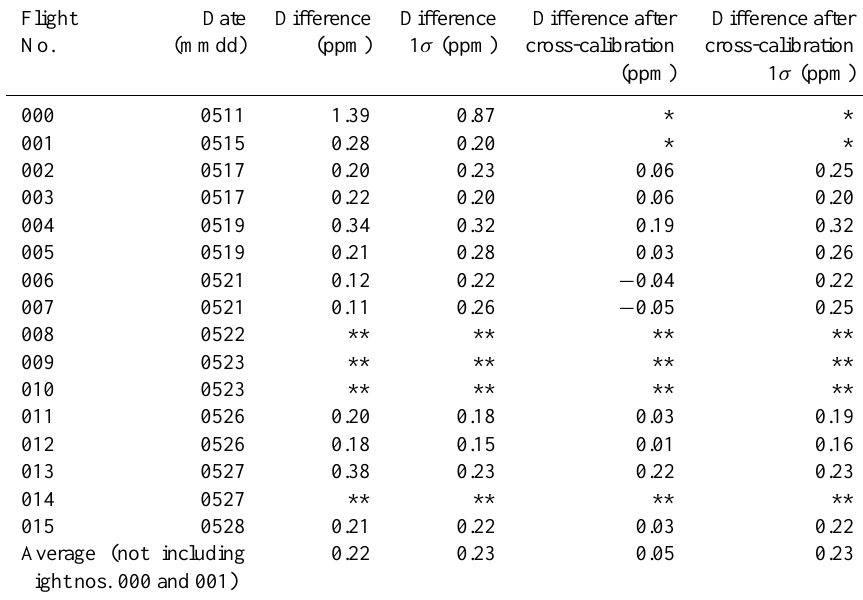
Table 1. Comparisons of CO 2 mixing ratio measurements from the CRDS analyzer and the NDIR analyzer on the Bandeirante EMB 110 aircraft during the BARCA phase B campaign in Brazil in